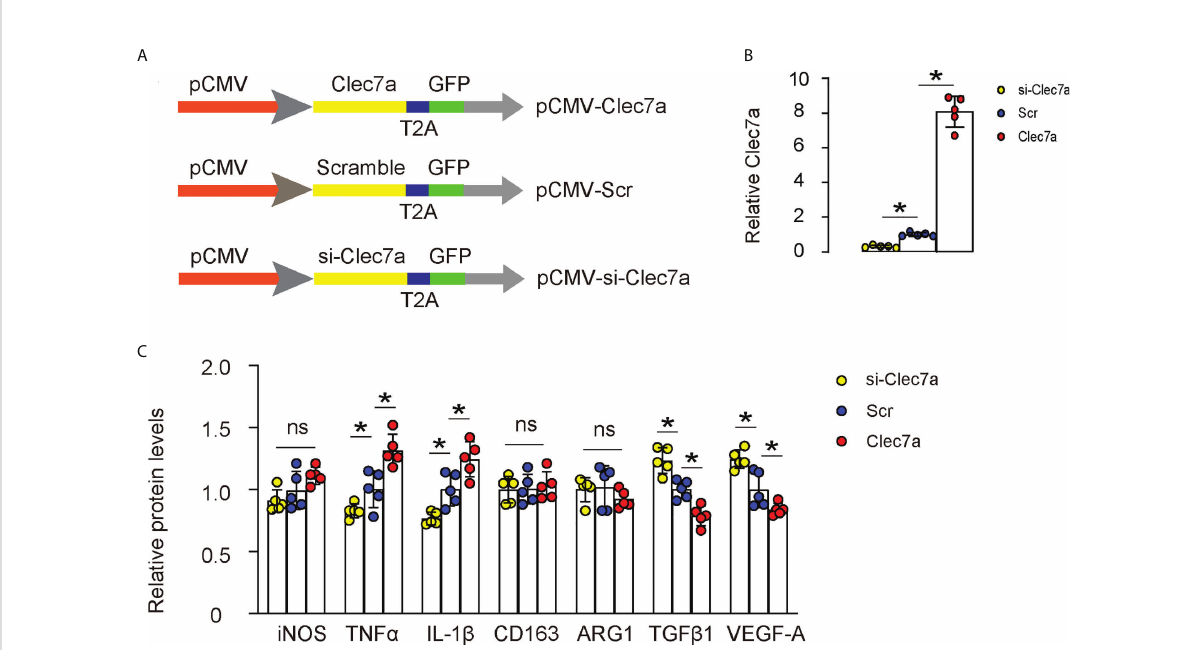
FIGURE 3 Clec7a does not alter polarization of M1 or M2 macrophages. (A) Schematic of generating plasmids carrying Clec7a or si-Clec7a or scramble control under a cytomegalovirus (CMV) promoter. (B) ELISA for Clec7a levels. (C) ELISA for iNOS, TNF a , IL-1 b , CD163, ARG1, TGF b 1 and VEGF-A. *p<0.05. ns, no signi fi cant.